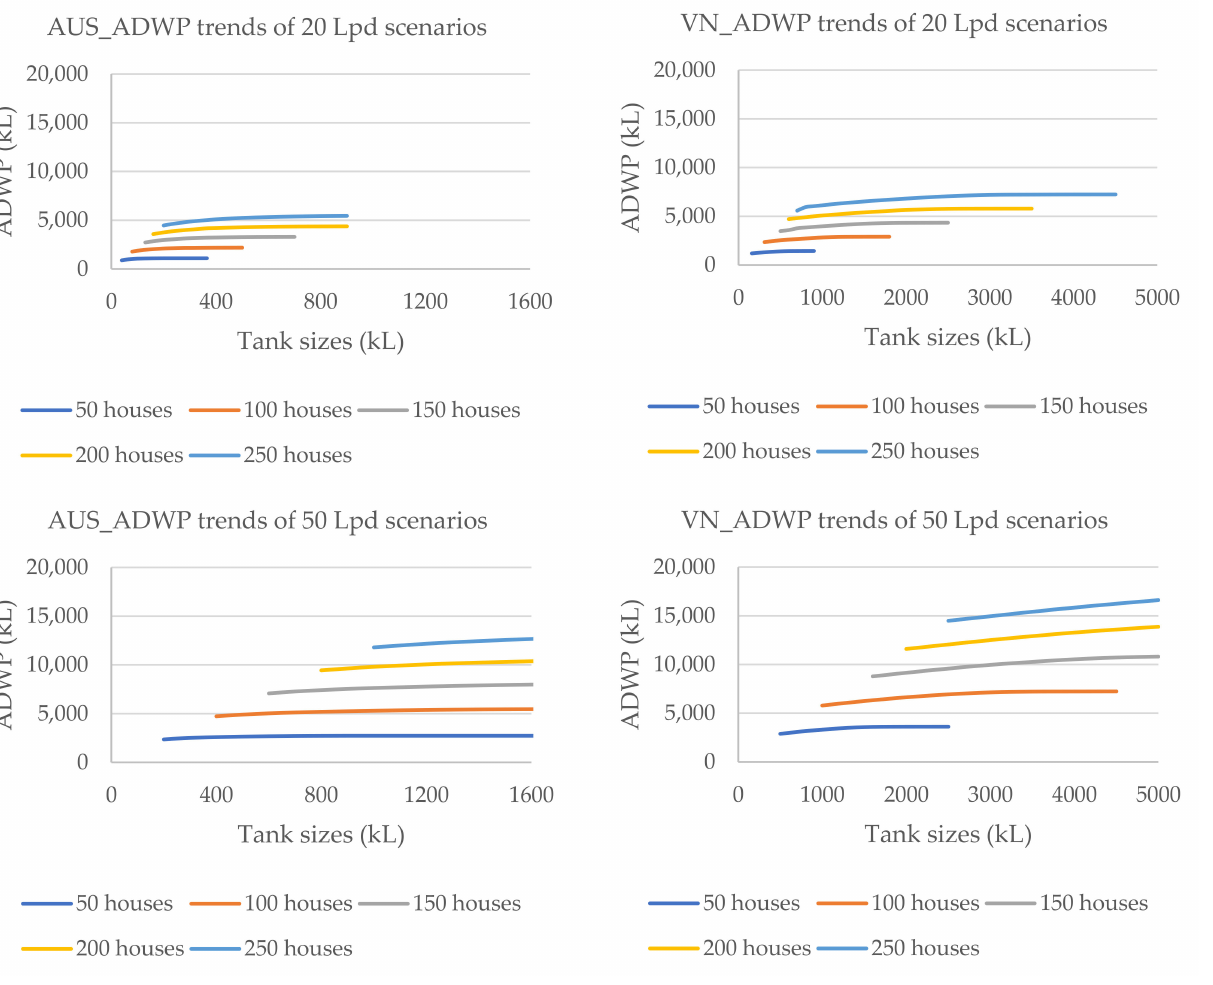
Figure 8. ADWP trends with respect to tank sizes and scenarios for Australian and Vietnamese RWH